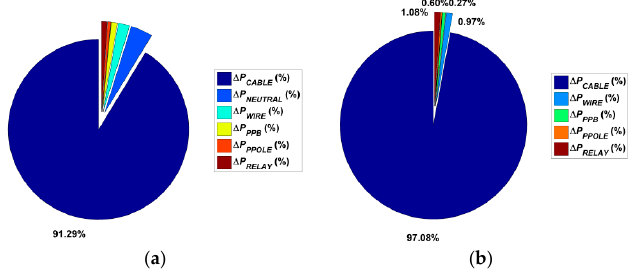
Figure 5. Power losses in elements of the lighting system as percentages of the total losses Δ P TOTAL for ( a ) three-phase system, ( b ) single-phase system.